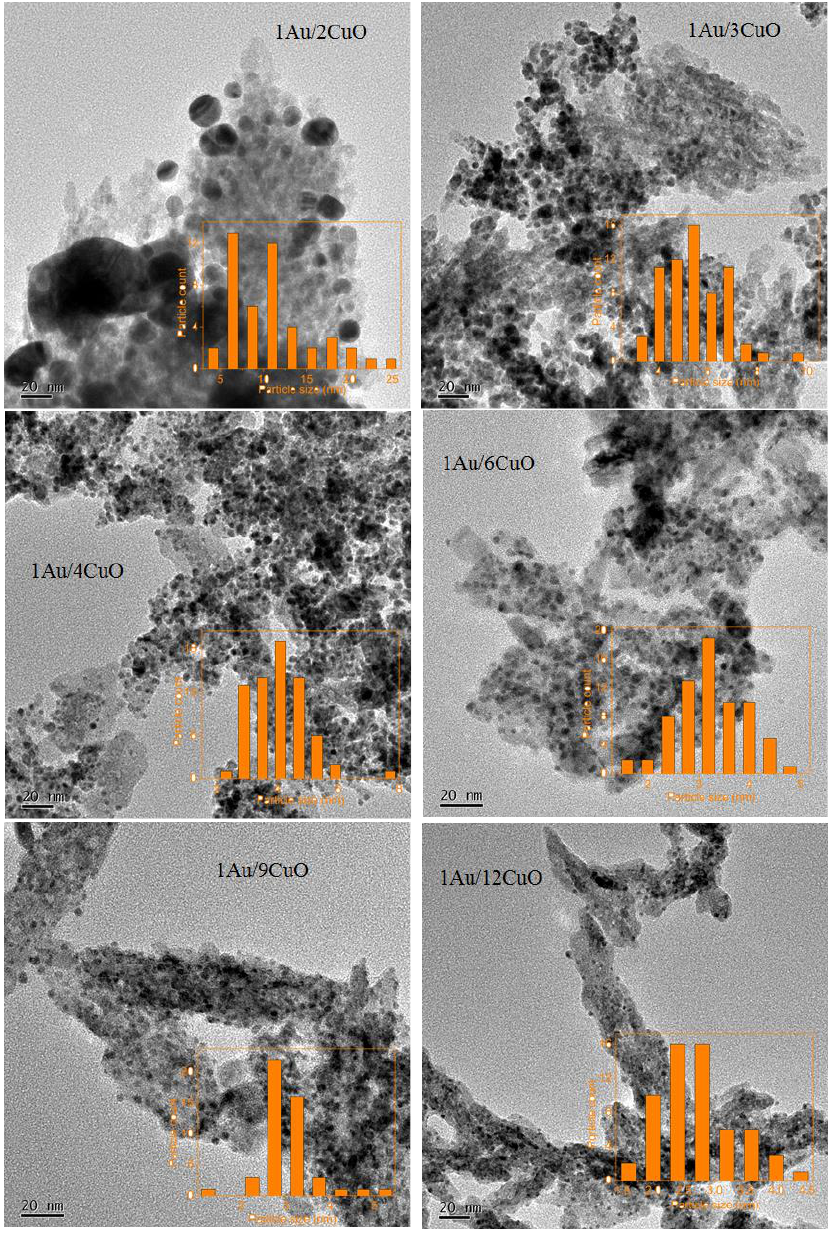
Figure 4. TEM images of Au/CuO with different CuO contents in Au/CuO.